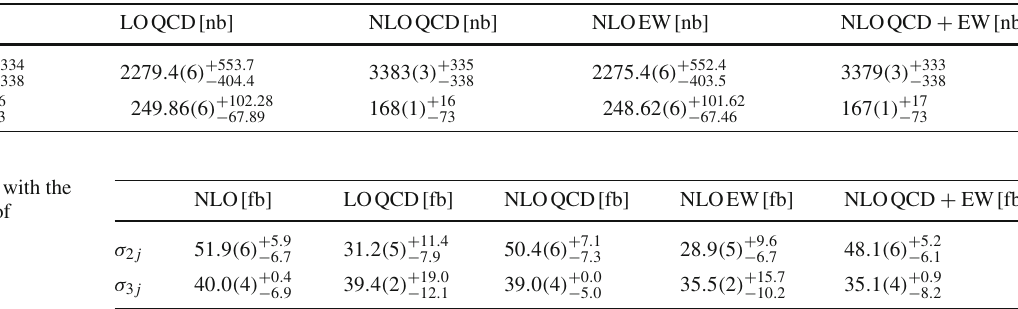
Table 3 Fiducial cross sections for two- and three-jet production and their corresponding scale uncertainties for a leading-jet selection of p T ( j 1 ) > 80 GeV. The respective cross section definitions are given in Eqs. (5) and